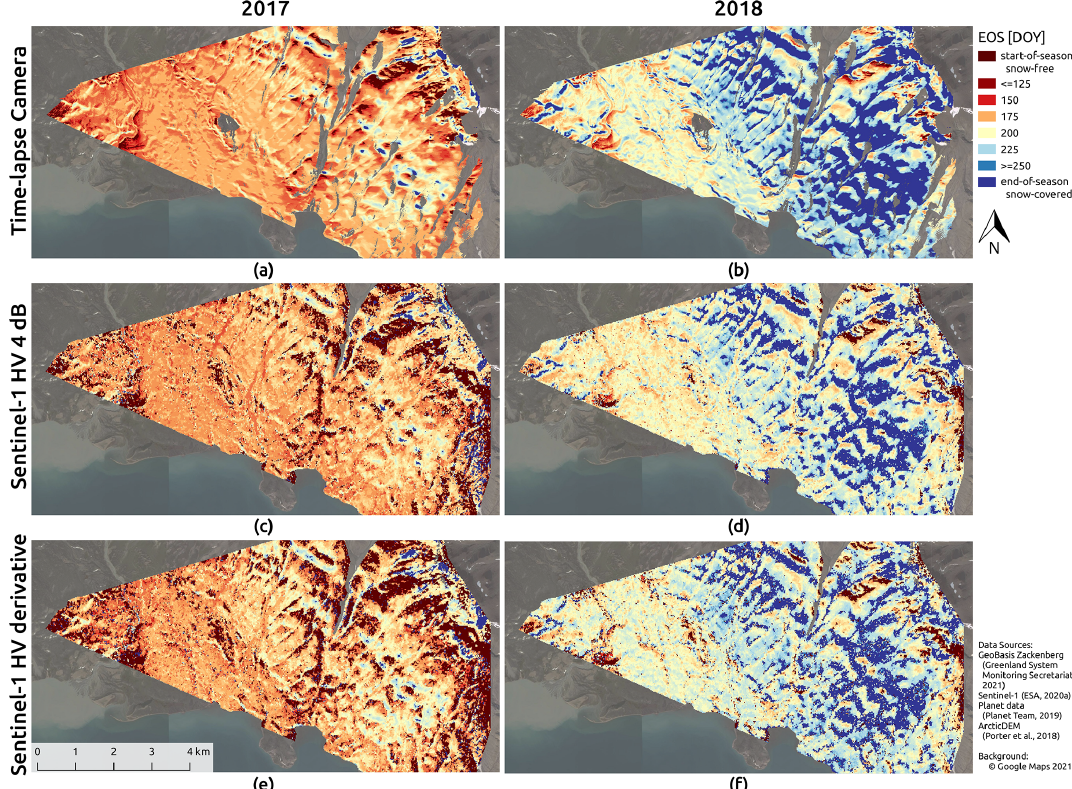
Figure 11. Melt layers (composites of day of year (DOY) for end of snow cover (EOS), start-of-season snow-free areas and end-of-season snow-covered patches) of Zackenberg: (a–b) reference product by the time-lapse imagery with 2.5m resolution for (a) 2017 and (b) 2018; subset of the generated S-1 product with 20m resolution bounded by the camera field of view with global parameter configuration (polariza- tion: HV; threshold t : 4dB) for (c) 2017 and (d) 2018; (e–f) the same area of the S-1 product with the derivative approach for (e) 2017 and (f)